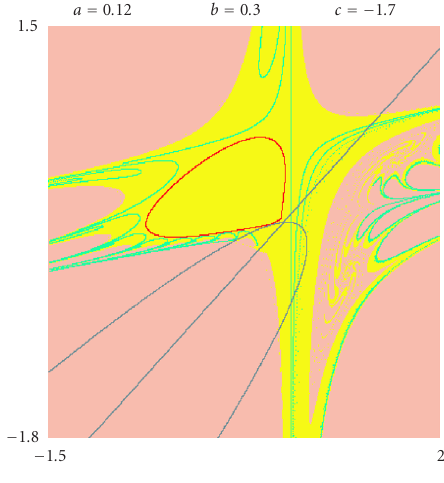
Figure 4.1. The attractor is the closed curve, its basin is colored clear